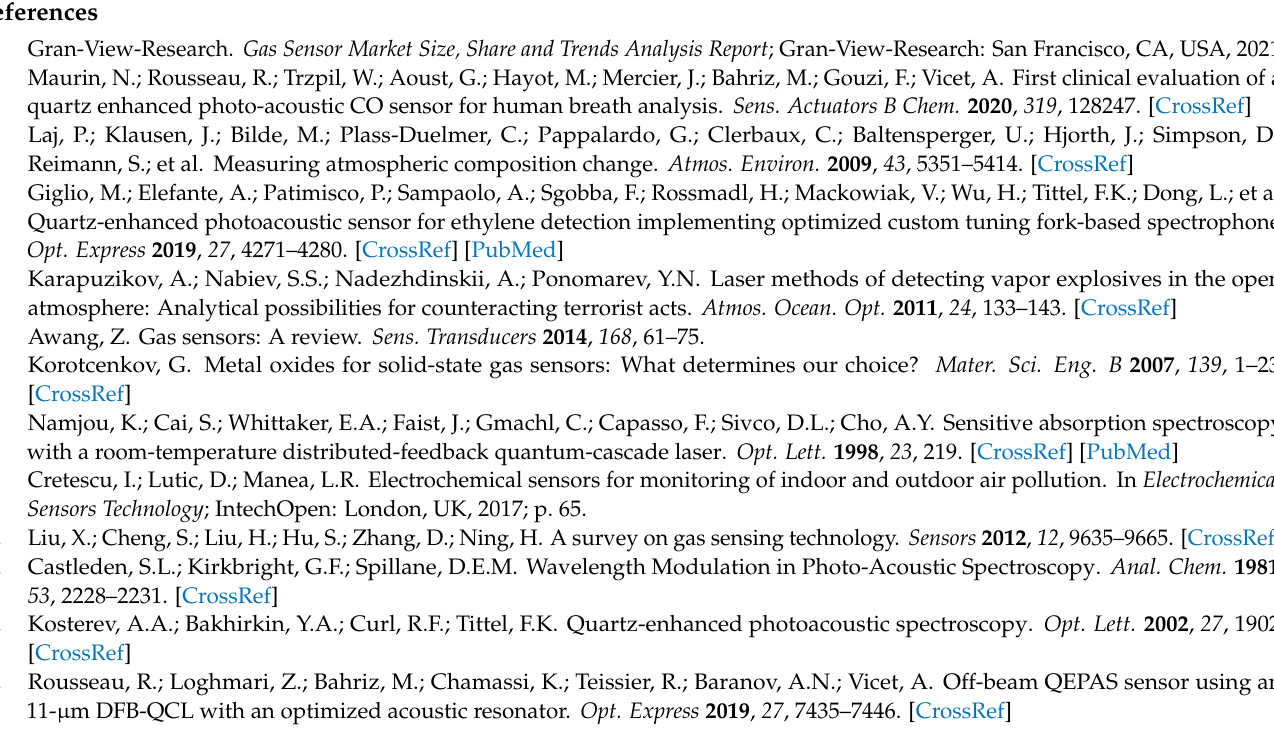
Figure A5. Frequency study for two geometries of cantilever with a distance between the electrodes d = 10 µ m: geometry optimized for SNR ( b = 180 µ m, h = 2 mm) and geometry optimized for V out ( b = 25 µ m, h = 300 µ